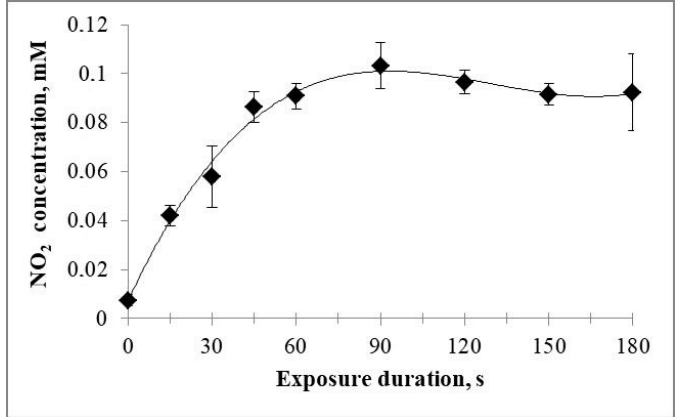
Figure 3. The dependence of nitrite concentration in the physiological solution on the time of processing by direct piezodischarge. The distance between the piezotransformer and the solution surface was 0.5 mm. The temperature of the surrounding medium was 20 ± 2 °C, and the air humidity was 70 ± 3%. In detail, the experimental conditions are described in the Section 2.